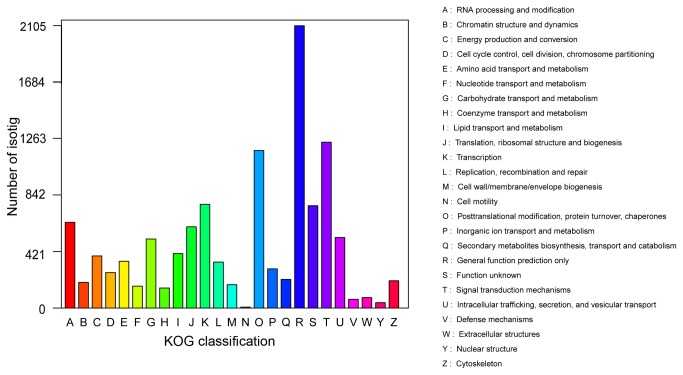
Histogram of KOG classification.All isotigs were aligned with genes in the KOG database to predict and classify possible functions. Of the 41,873 isotigs with nr hits 10,212 were assigned to 25 KOG classifications.